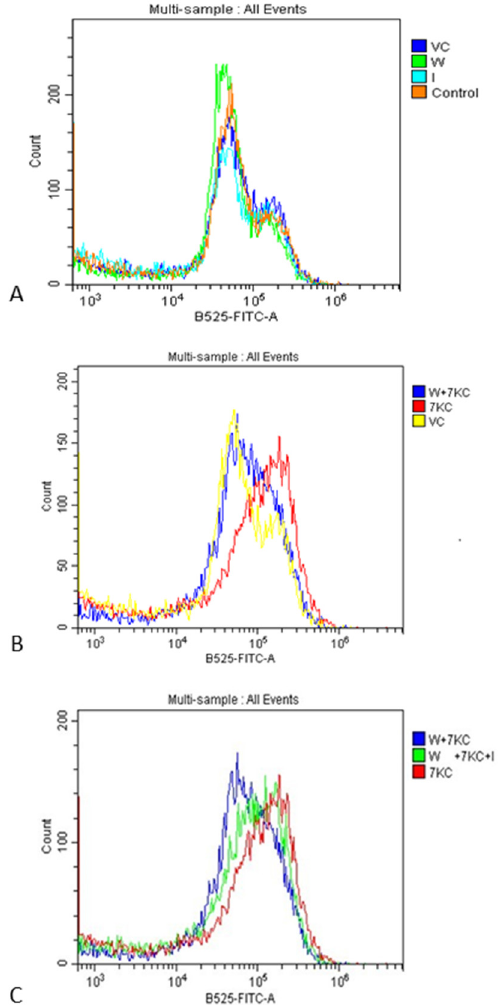
Figure 4. ( A – C ) Single parameter histograms showing comparison between various treatment groups in terms of fluorescence intensity for DCFDA. X axis indicates fluorescence intensity, detected at 525 nm. Y axis indicates the number of cells. A rightward shift of the curve indicates a greater number of cells with higher intensity, i.e., greater levels of ROS. A: blue line: Vehicle control (VC). Green line: withanolide A only (W). Turquoise line: mifepristone only (I). Red line: untreated control. No difference from untreated control or vehicle control is seen with withanolide A treatment, or mifepristone treatment only. ( B , C ): Yellow line: Vehicle control; Red line: 7KC only; Blue line: withanolide A with 7KC co-incubation; Green line: withanolide A with mifepristone and 7KC co-incubation. Withanolide A has an effect in reducing ROS formation by 7KC, and this effect was abrogated by mifepristone.